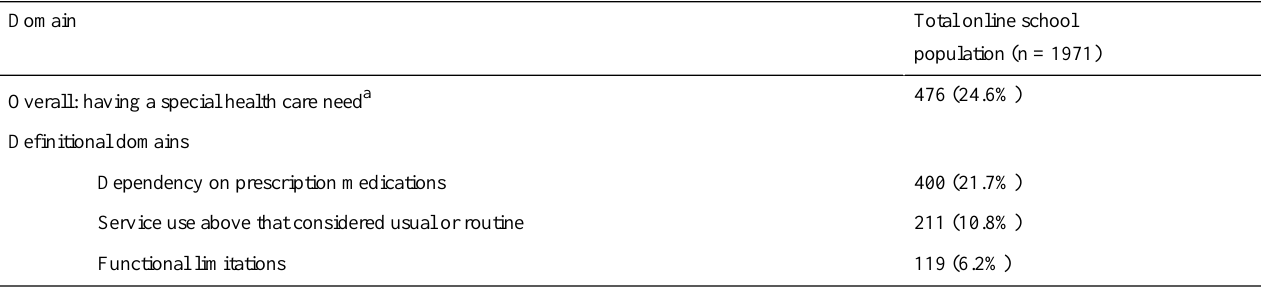
Table 2. Domains of the Children with Special Health Care Needs (CSHCN) Screener.